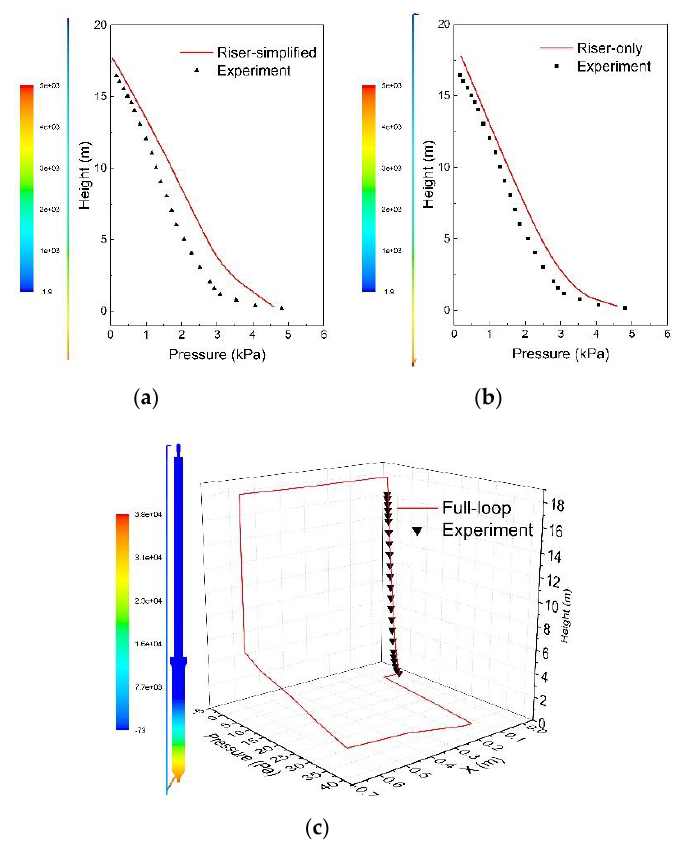
Figure 6. Comparison of pressure distribution in the CFB among different methods. ( a ) Riser-simplified simulation, ( b ) riser-only simulation, ( c ) full-loop simulation.